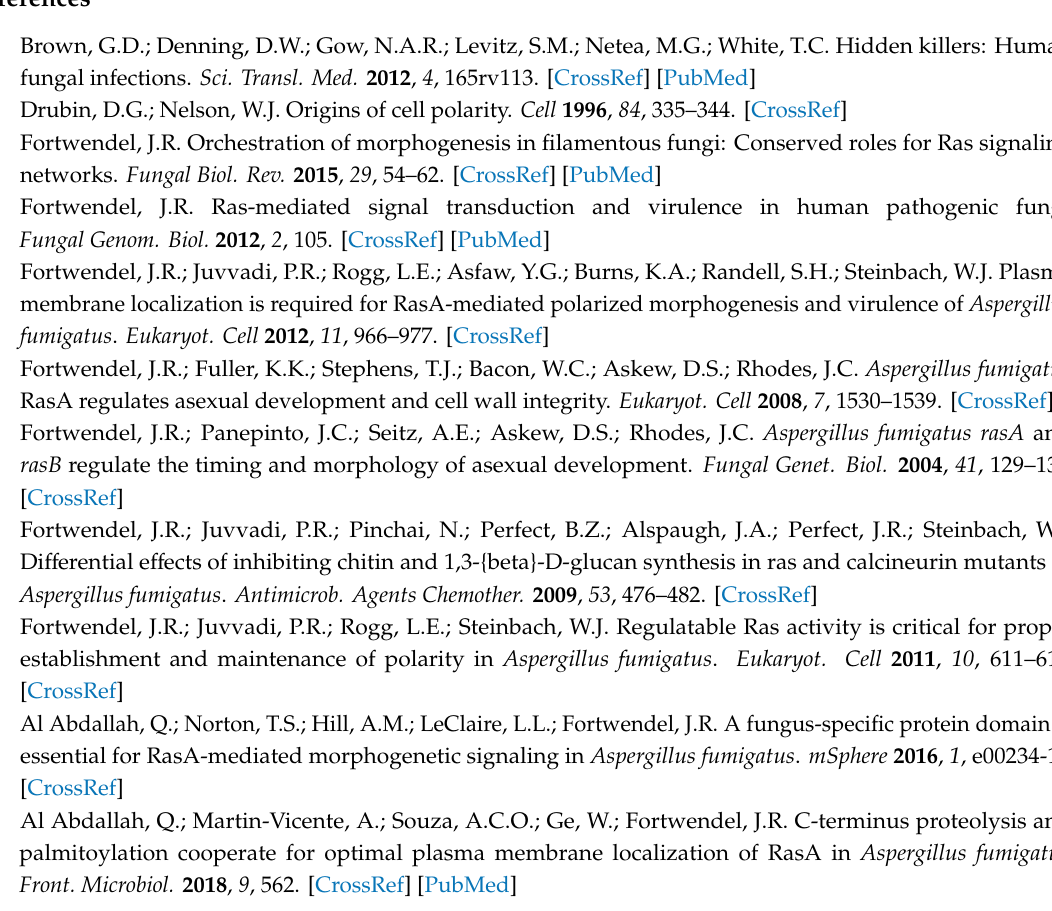
Figure S1: Sequence alignment of Rsr1 from Saccharomyces cerevisiae and Aspergillus fumigatus , Figure S2: Deletion of rsrA does not a ff ect hyphal morphology in A. fumigatus, Figure S3: Loss of rsrA does not increase susceptibility to oxidative, membrane or cell wall stress, Figure S4: The micromorphology of the control strain ∆ akuB - pyrG + , ∆ rsrA and ∆ rasA is not altered by doxycycline